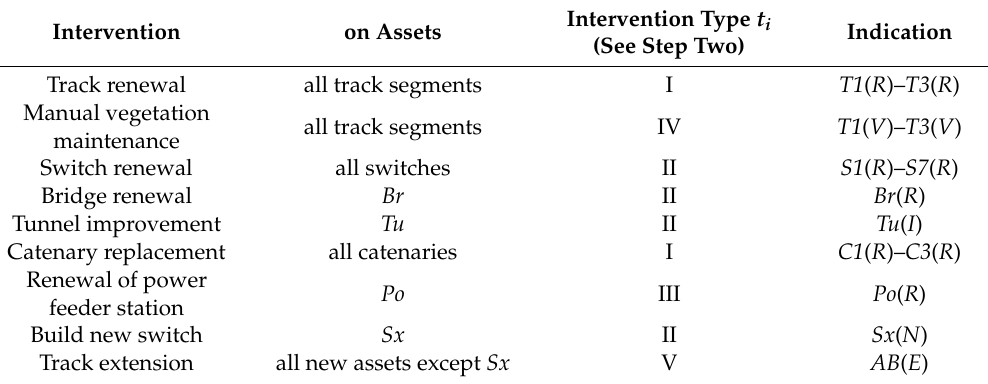
Table 1. Candidate interventions.